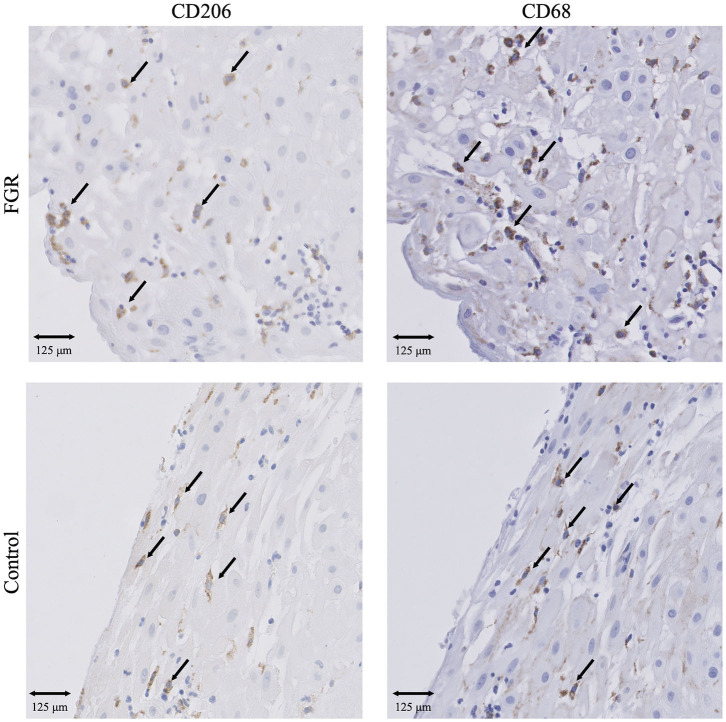
IHC results of macrophages in FGR and controls. Presence of CD68+ macrophages and CD206+ M2 macrophages in FGR (n = 250) and controls (n = 42). 20x magnification. Arrows set as example of CD68+ and CD206+ cells, not all positive cells are indicated. FGR, fetal growth restriction.